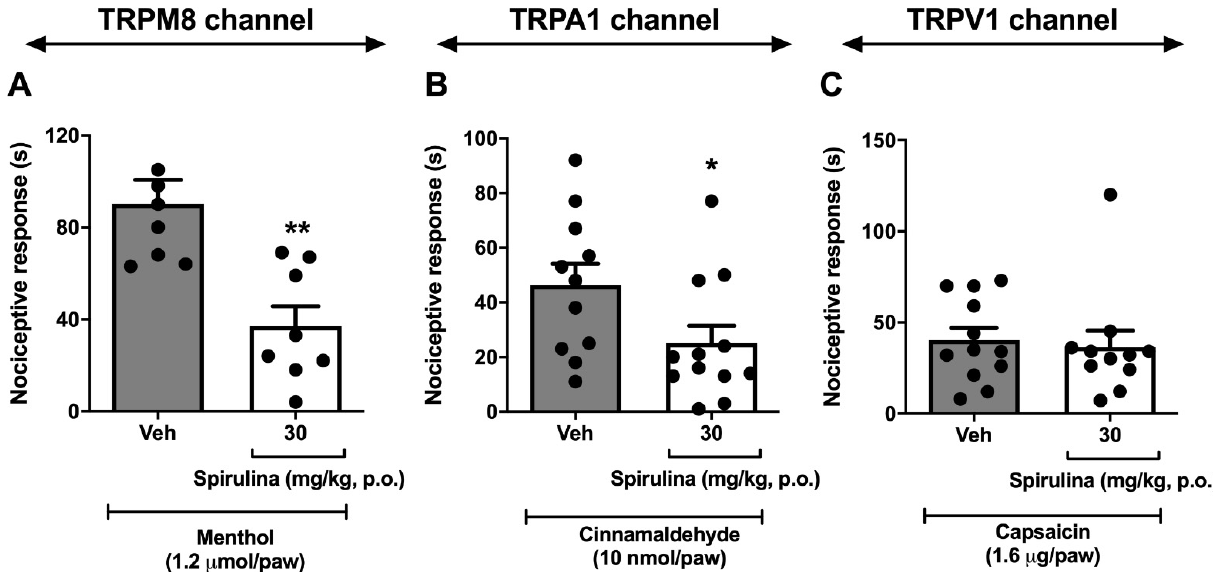
Figure 5. Effect of Spirulina on nocifensive behavior induced by menthol (panel A ), cinnamaldehyde (panel B ), and capsaicin (panel C ). Each column represents the mean ± SEM of 7–12 animals/group, with a black dot showing individual mice. Asterisks denote the levels of significance compared to the control group (Veh). ** p < 0.001, * p < 0.05 using one-way